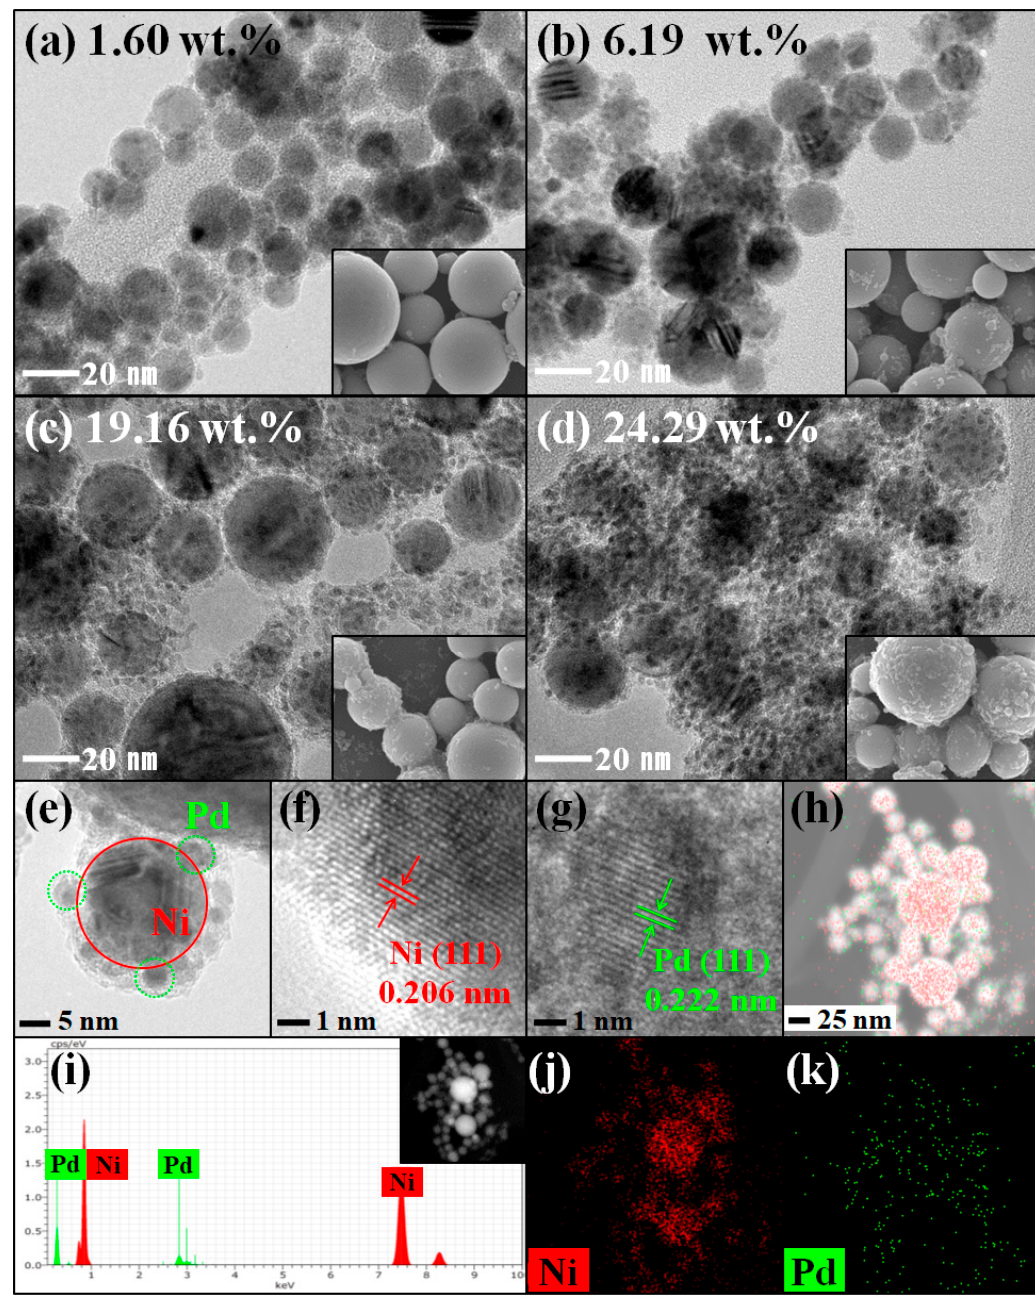
Figure 2. ( a – d ) High-resolution transmittance electron microscopy (HRTEM) images of Ni/Pd bimetallic NPs with various Pd loadings. ( e ) Pd NPs on the surface of Ni NPs. ( f – k ) selected area electron diffraction (SAED) and energy dispersive X-ray spectroscopy (EDS) patterns of Ni and Pd